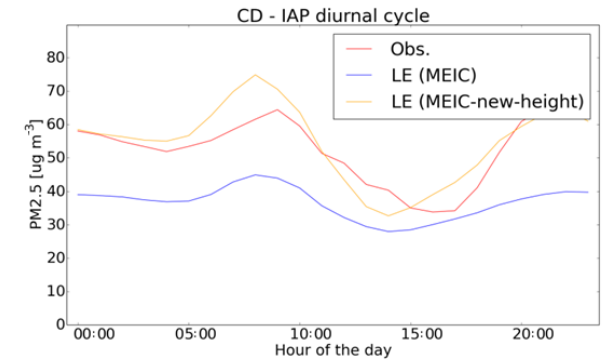
Figure 12. Annually averaged diurnal evolution of the PM 2 . 5 con- centrations in the city of Chengdu simulated for different values of the particulate injection height. Calculations by the LOTOS- EUROS (LE)